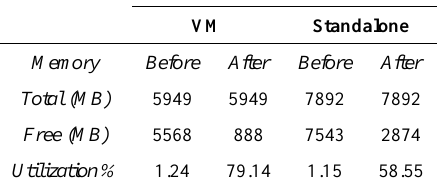
Table 3. Memory utilization in scenario